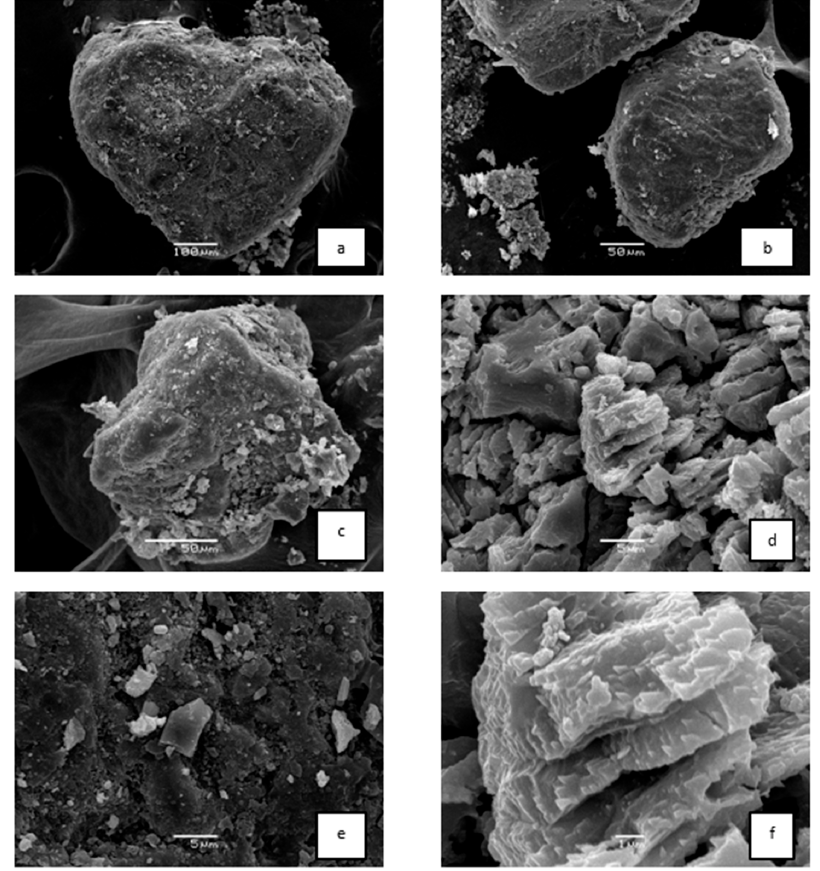
Figure 6. Mineral grain morphology. ( a , b )—quartz grains of various shapes; ( c , e )—quartz grain covered with film; ( d , f )—Weathered feldspar grains covering the grain of quartz. SAM JSM-6380 LA. The scale is 100 μ m ( a ), 50 μ m ( b , c ), 5 μ m ( d , e ), 1 μ m ( f ).